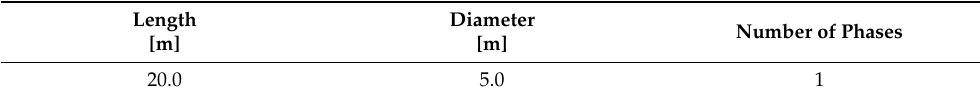
Table 2. Cylindrical computational domain dimensions.